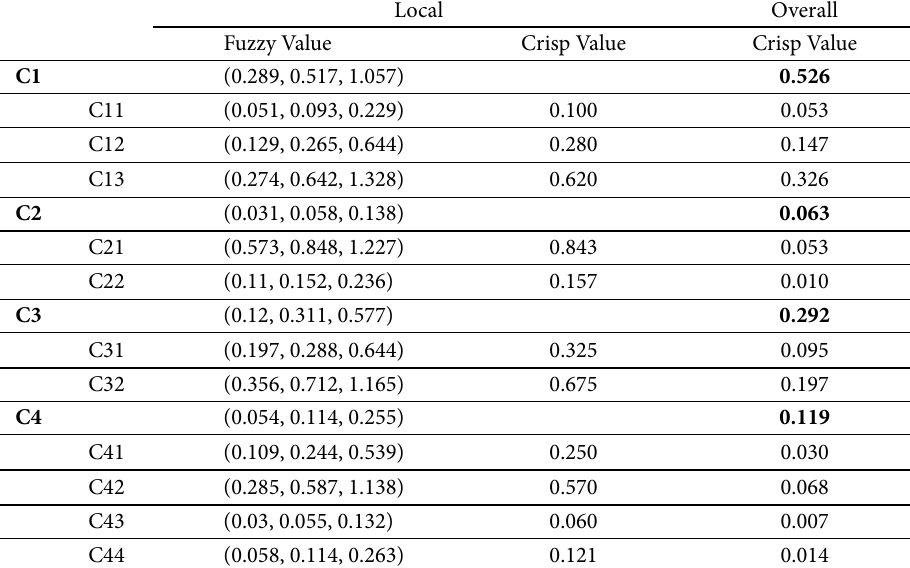
Table 7. The local and overall values of criteria and sub-criteria for health investment Local Overall Fuzzy Value Crisp Value Crisp